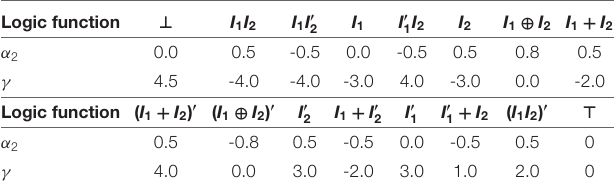
TABLE 3 | List of the system parameters α 2 and γ used to emulate each logic function. Logic function